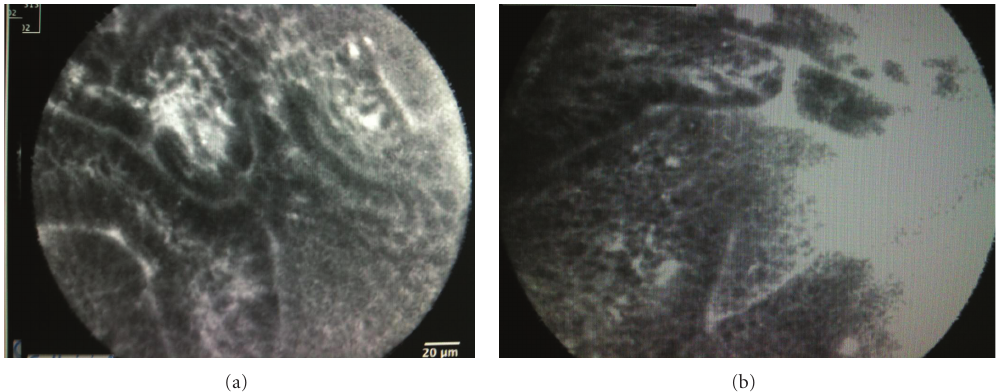
Figure 2: (a) Abnormal epithelium with decreased uptake of fluorescein in a patient with primary sclerosing cholangitis seen during a confocal procedure using a GastroFlex. (b) Abnormal epithelium with decreased uptake of fluorescein with loss of architecture integrity in a patient with primary sclerosing cholangitis seen during a confocal procedure using a